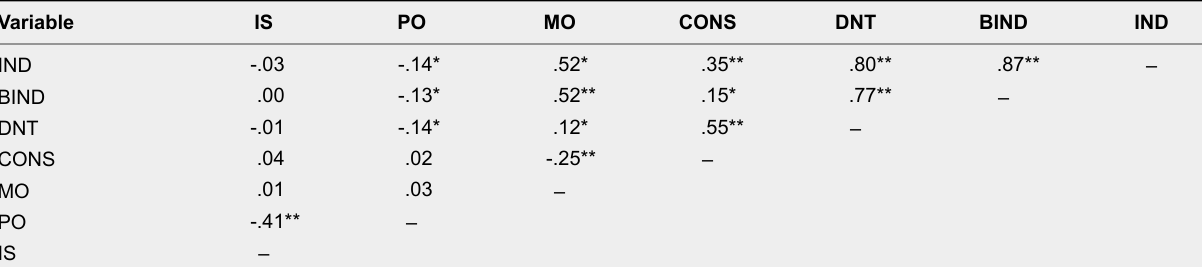
Pearson’s Correlations Between Continuous Variables in Study 1